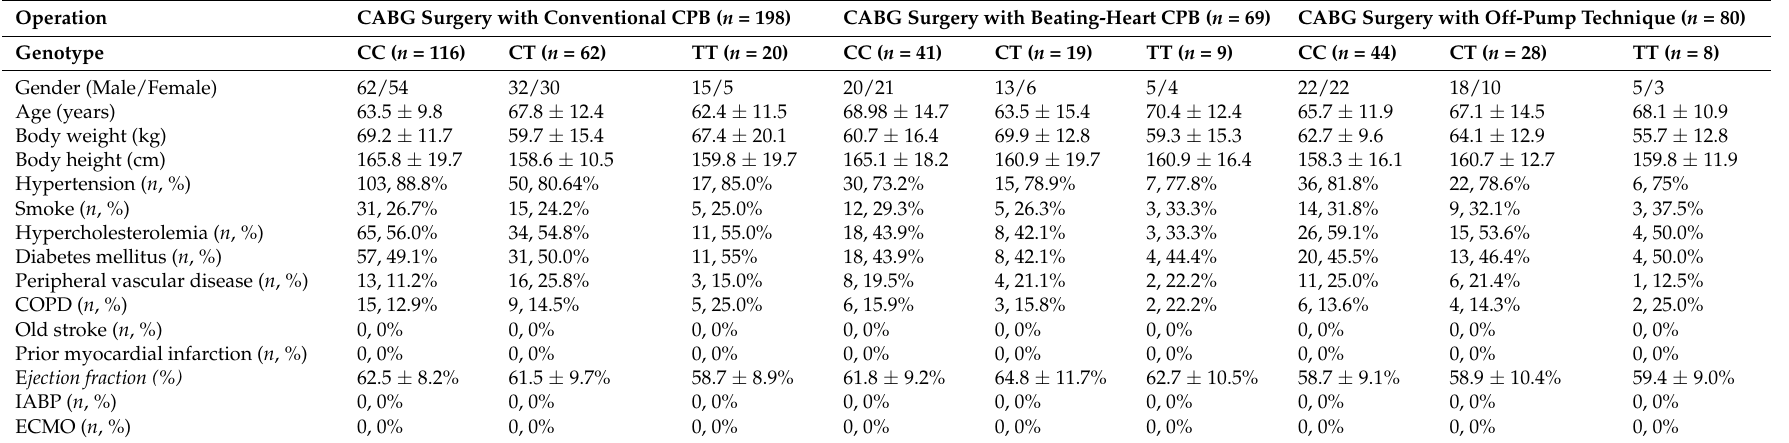
Table 2. Demographic characteristics ( n = 347) before surgery in elective CABG patients.